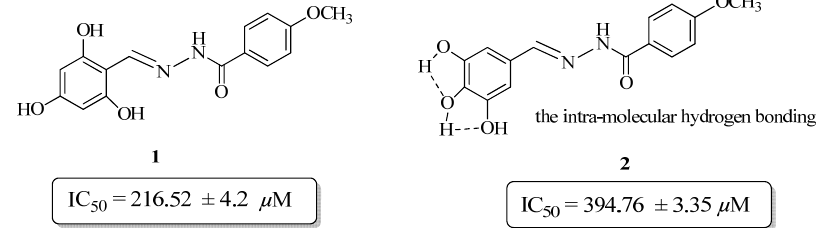
Figure 1. Comparison of the anti-glycation activity of compounds 1 and 2